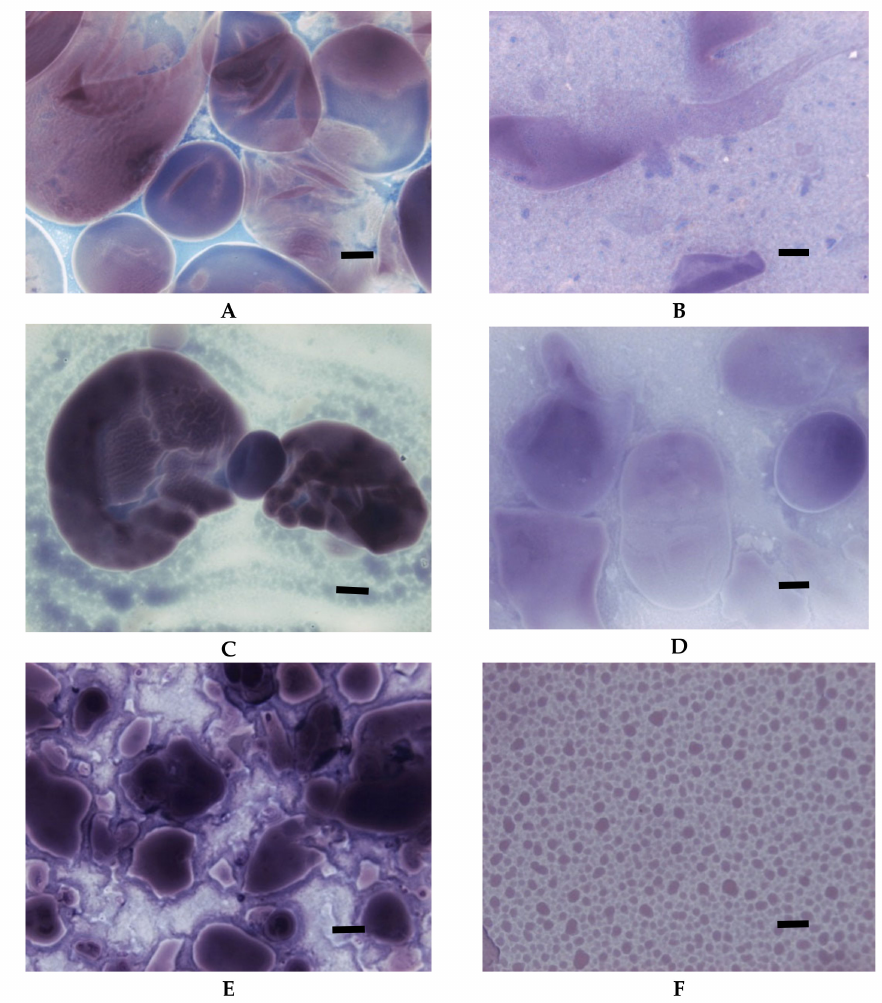
Figure 6. LM micrographs (20 × ) of oxidised starch of potato origin with di ff erent degrees of substitution incubated at initial and advanced stages of gelatinisation: ( A ) DS = 0.0014; 65 ◦ C, ( B ) DS = 0.0014; 90 ◦ C, ( C ) DS = 0.0036; 65 ◦ C, ( D ) DS = 0.0036; 90 ◦ C, ( E ) DS = 0.018; 65 ◦ C, ( F ) DS = 0.018; 90 ◦ C, (Bar-20 µ